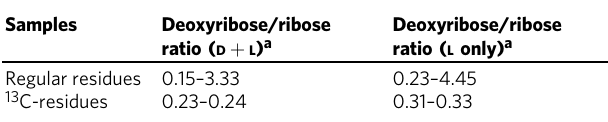
Table 2 Ratios between the abundances of 2-deoxyribose and ribose in the residues Samples Deoxyribose/ribose Deoxyribose/ribose ratio ( D + L ) a ratio ( L only) a Regular residues 0.15 – 3.33